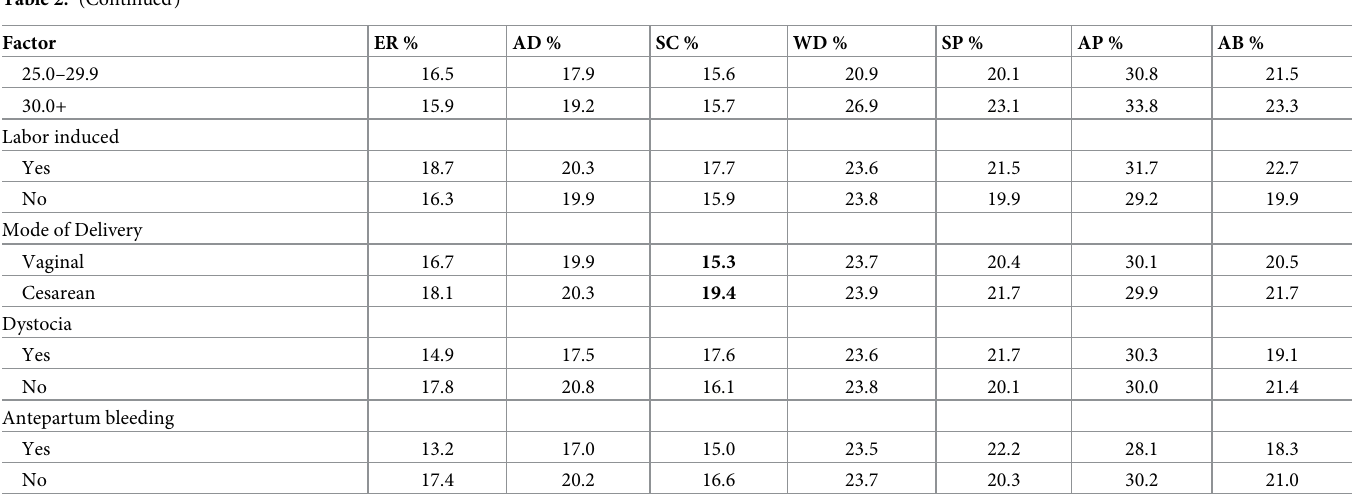
outcomes. Offspring of women who reported having an infection during pregnancy scored significantly higher on the CBCL syndrome scales measuring emotionally reactive, anxious/ depressed, and withdrawn. The condition of headache/migraine during pregnancy was not significantly associated with any of the CBCL syndrome scales. Several variables were signifi- cantly associated with all of the CBCL syndrome scale outcomes: alcohol consumption